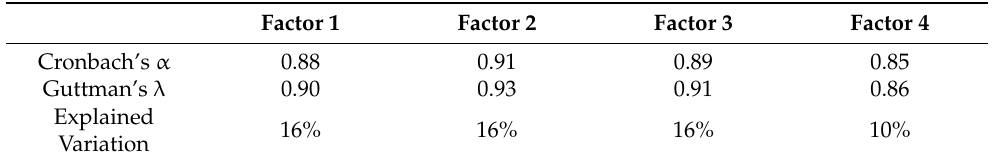
Table 1. Reliability and internal consistency of the factors quantified by Cronbach’s α and Guttman’s λ as well as explained variation per factor. Factor 1 Factor 2